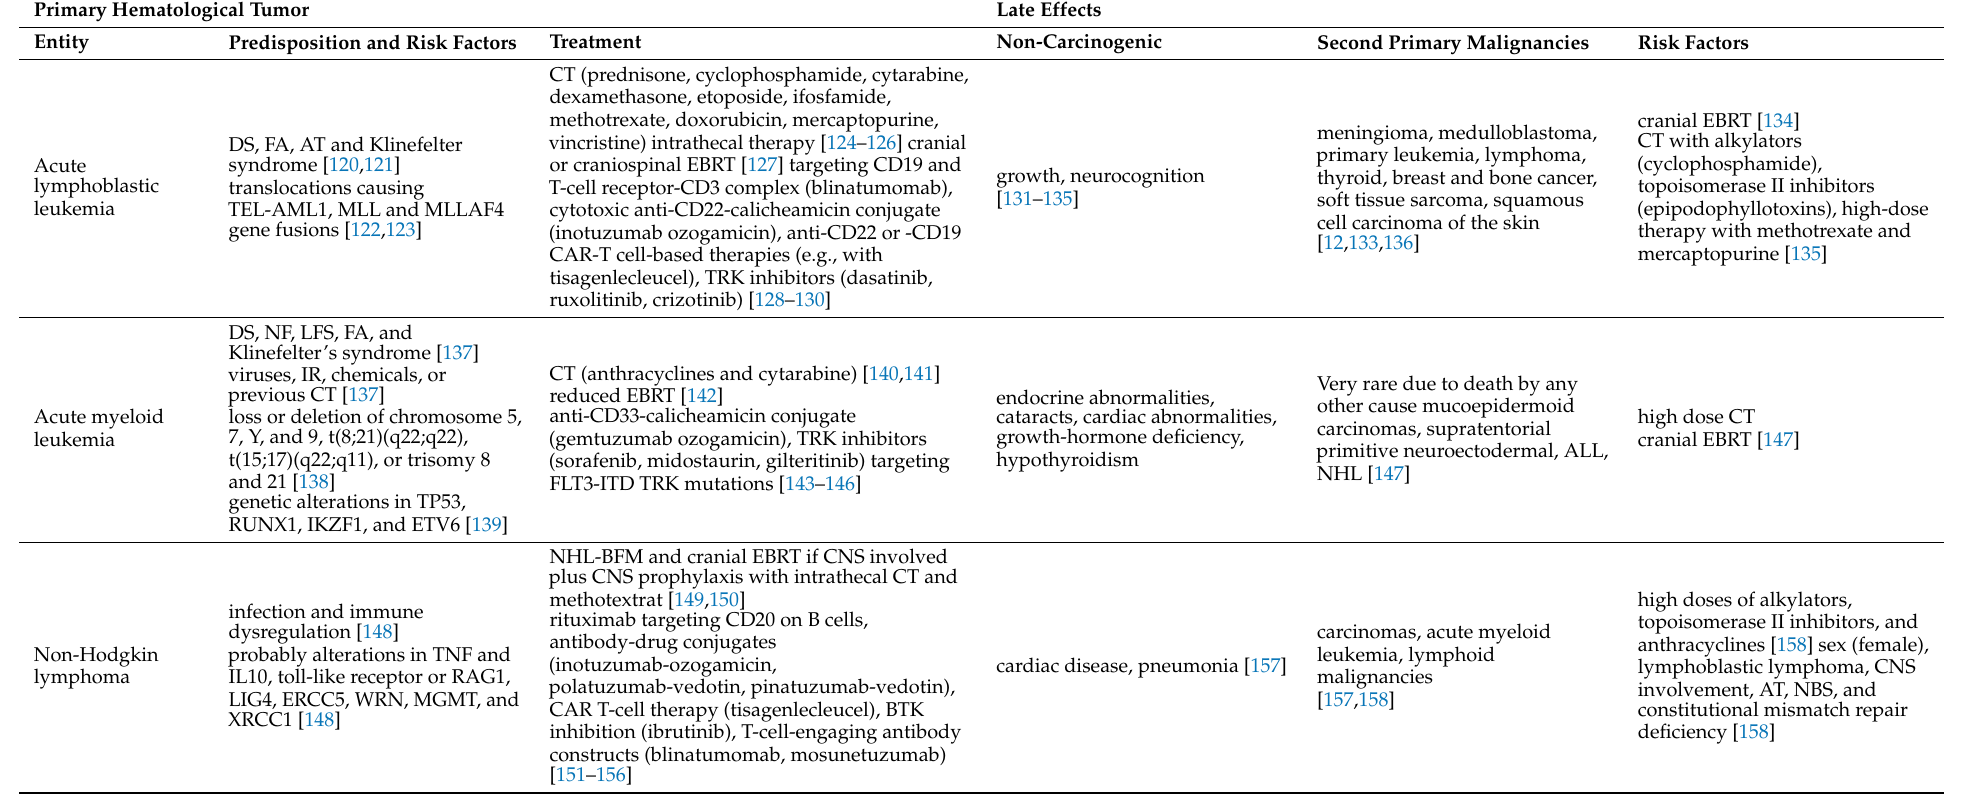
Table 1. Overview of the major primary hematologic tumors of childhood, risk factors for their development, current treatments, non-cancerous late effects, most common second primary malignancies, and risk factors for their